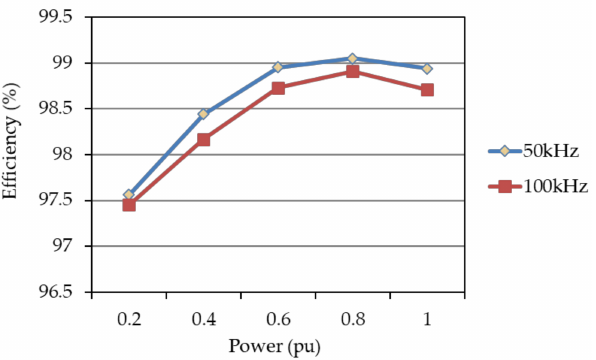
Figure 19. Efficiencies of the proposed GaN-based synchronous buck converter at different switc- hing